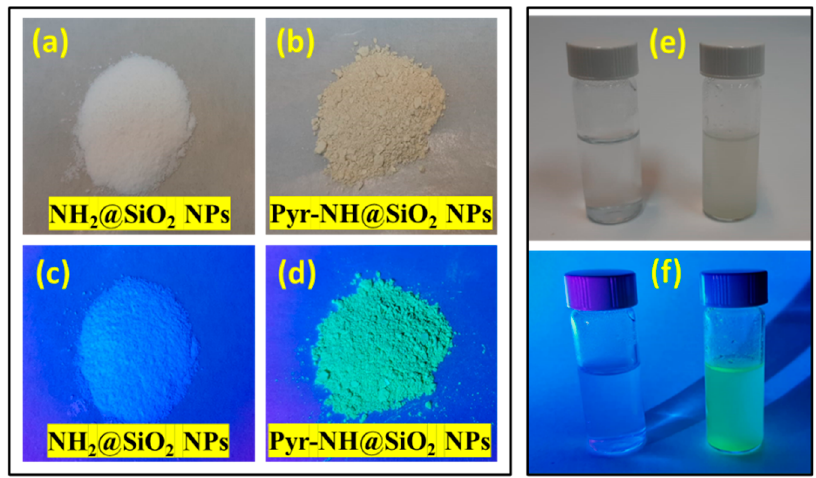
Figure 5. Pictograms of as-synthesized powdered samples under ( a , b ) normal light and ( c , d ) UV light illumination. The fluorescence properties of NH 2 @SiO 2 NPs and Pyr-NH@SiO 2 NPs in deionized water under ( e ) normal light and ( f ) UV light.